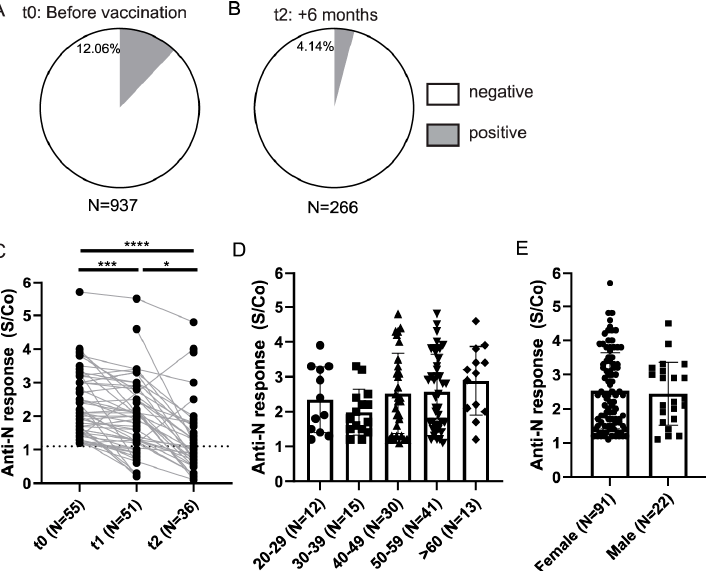
Figure 4. Anti-Nucleocapsid antibody response in HCWs. ( A ) Anti-Nucleocapsid (anti-N) serocon- version rates in HCWs prior to vaccination and ( B ) 6 months after the full vaccination (t2) (S-positive individuals at t0 and N-positive at t0 and t1 were excluded). ( C ) Comparison of the anti-Nucleocap- sid antibody S/Co between paired seroconverted samples. ( D ) Levels of anti-Nucleocapsid antibod- ies in sera of seroconverted individuals at t0 stratified on the basis of age and ( E ) gender. S/Co, Signal to cut-off ratio; dashed line indicates cut-off value (S/Co = 1.1). Statistical test: Mixed-effects analysis with Tukey’s multiple comparisons test ( C ), p value **** p < 0.0001,p value *** and * p<0.05.